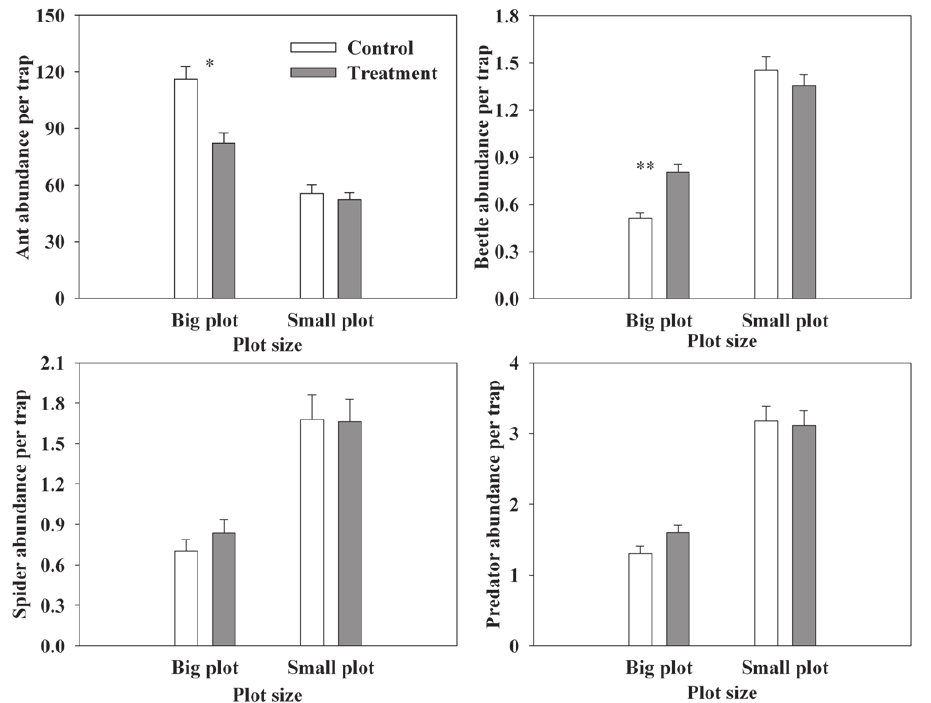
Figure 2. The impacts of excluding ants from the canopy on the abundance of ground arthropods (Mean, SE, * represents p , 0.05, ** represents p , 0.01).